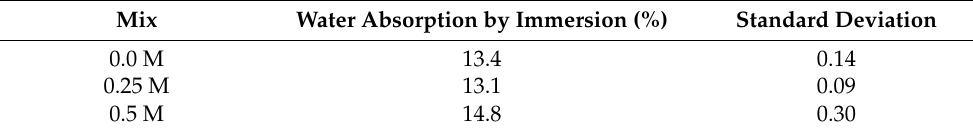
Table 4. Water absorption by immersion of the mortars with the CAA